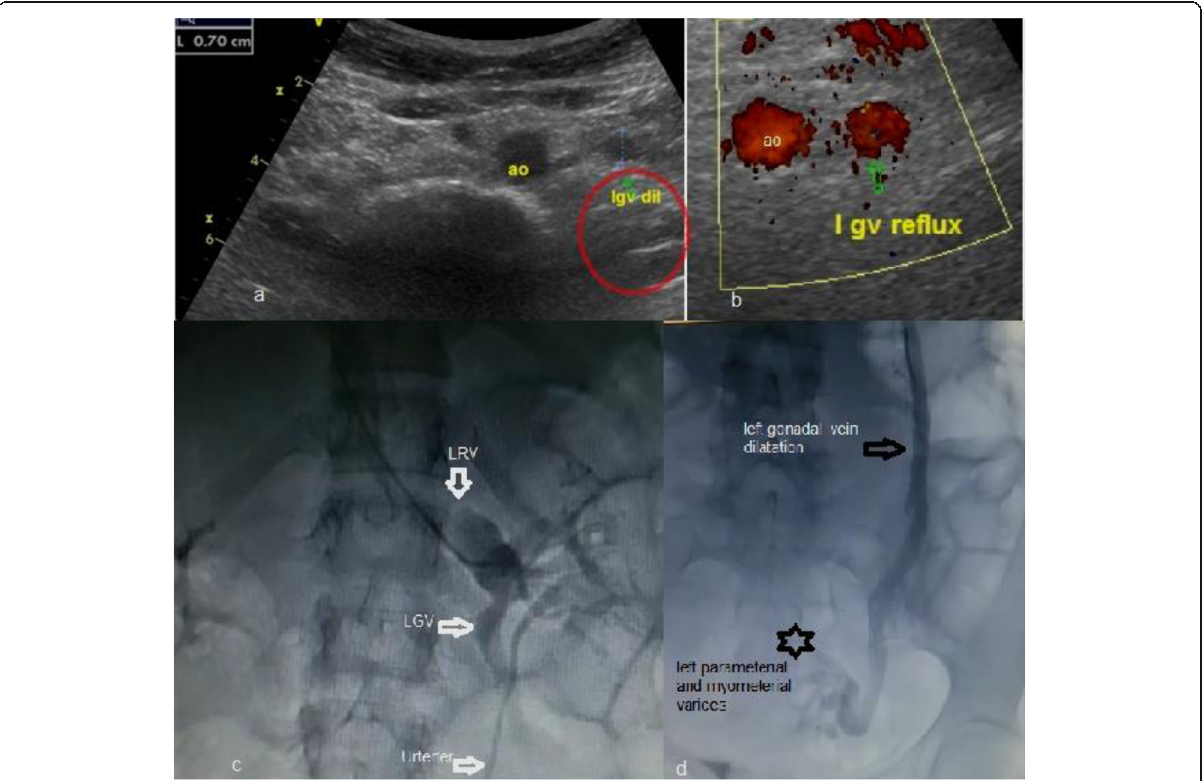
Fig. 4 a , b trans-abdominal ultrasound and color Doppler images, c , d left renal and left gonadal venogram. a Showing left gonadal vein dilatation (diameter=7mm between the calibers in a) seen anterior to the psoas muscle (red circle) in ( a ) and to the left of the infrarenal abdominal aorta (ao). Left gonadal vein reflux (coded in red) (open green arrow) in ( b ) was taking the same red color of the adjacent infra-renal abdominal aorta (Ao) c and d left renal (LRV) (white open vertical arrow) in ( c ) and left gonadal vein (LGV) (white horizontal arrow) in ( a ) angiogram showing dilated refluxing left gonadal vein (open horizontal black arrow) in ( d ) down to the left parametrial and myometrial varices (black asterisk) in ( d )